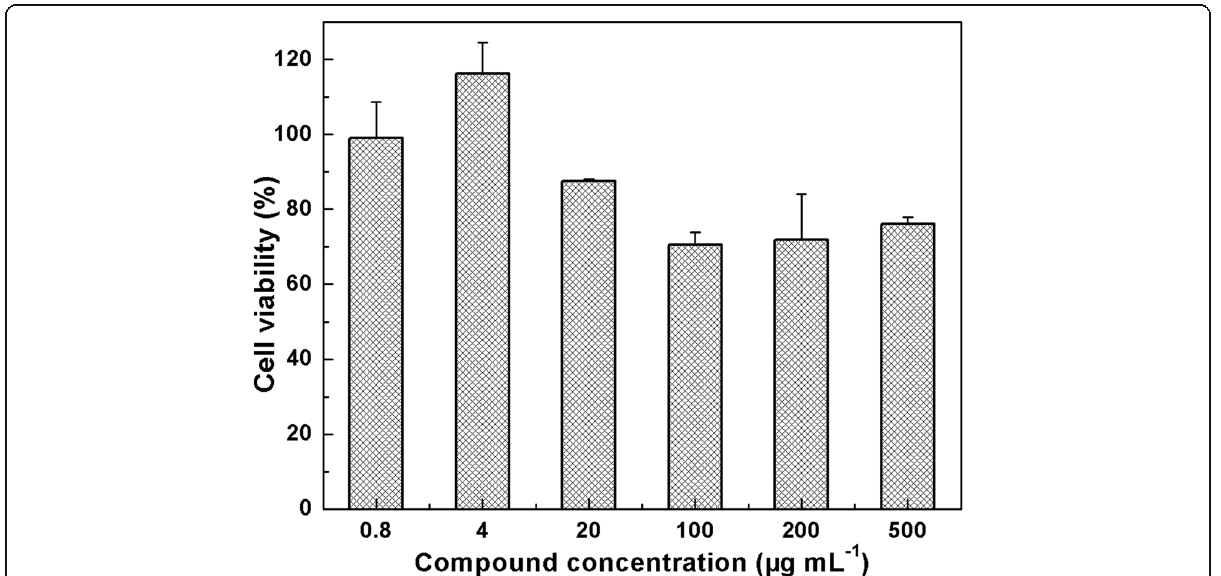
Fig. 6 Cell viability of A549 cells after 48-h incubation in the different concentration of